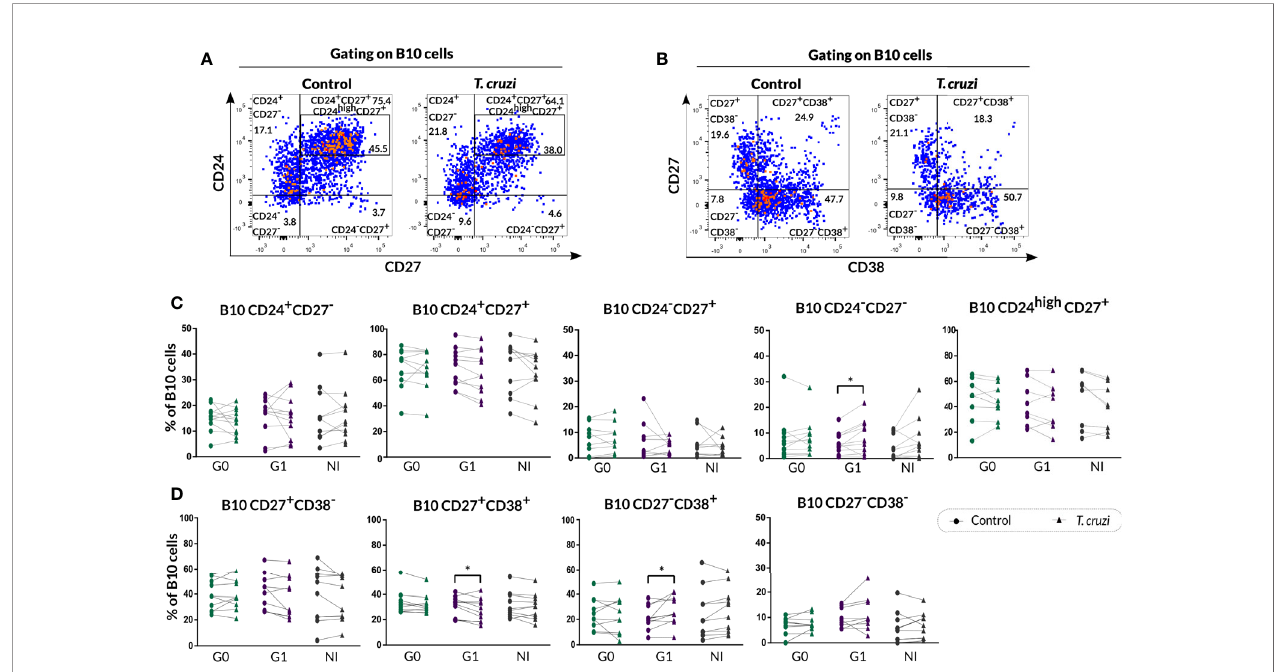
FIGURE 5 | Phenotypic distribution of B10 cells in terms of CD24-CD27 and CD27-CD38 markers expression from CCD patients and NI donors upon T. cruzi stimulation. (A, B) Dot plots corresponding to one NI donor showing the gating strategy used to identify B cell subsets de fi ned by CD24-CD27 and CD27-CD38 expression, respectively. (C, D) Frequencies of B cell subpopulations from CCD patients (G0, G1) and NI donors in Control or T. cruzi – stimulated samples, according to CD24-CD27 and CD27-CD38 markers expression, respectively. Each symbol represents data from one individual. Statistically signi fi cant differences are indicated with asterisks (*) p <